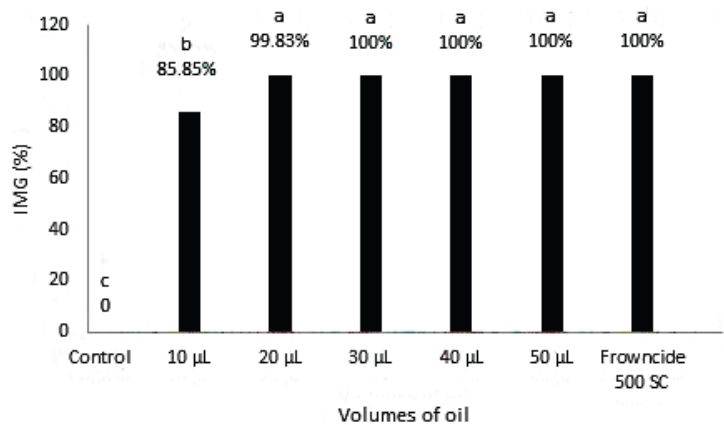
Figure 2 - Percentages of inhibition of mycelial growth of Sclerotinia sclerotiorum at different volumes of essential oils from P. aduncum inflorescences. Means followed by the same letter do not differ from each other by the Scott-Knott test.